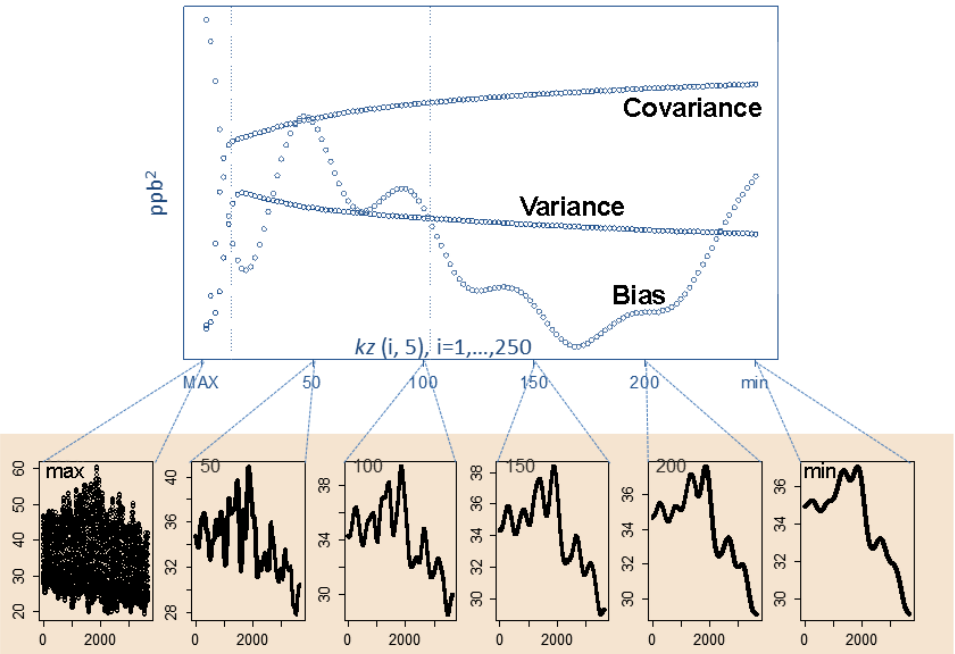
Figure 7. Example of the model complexity as time-resolved scale of the transport and dispersion processes: the minimum complexity (far right) is a poor time-resolving time series obtained as kz(250,5) ( ∼ 1 month). The complexity increases towards the left, with the scale of resolved processes becoming finer up to the maximum complexity (far left), which represents the full time series. The upper panel shows an example of how the curves of the error for covariance, variance and bias vary according to